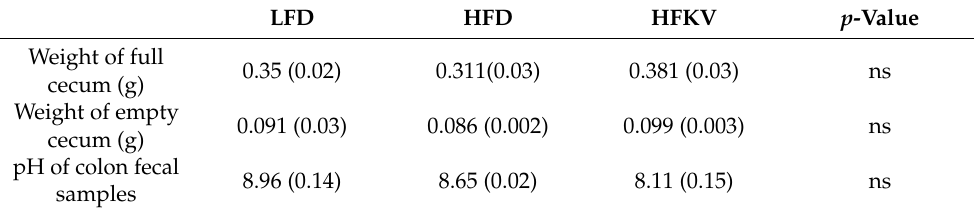
Table 4. Different fermentation variables in three diet